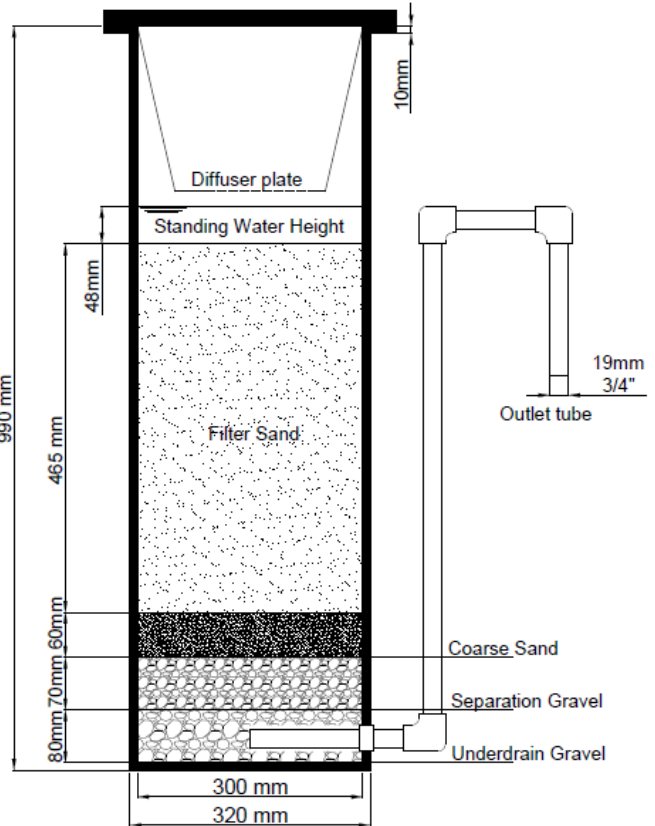
Figure 1. Cross section of the acrylic household scale biosand domestic filter (BSF) used in the experiments.